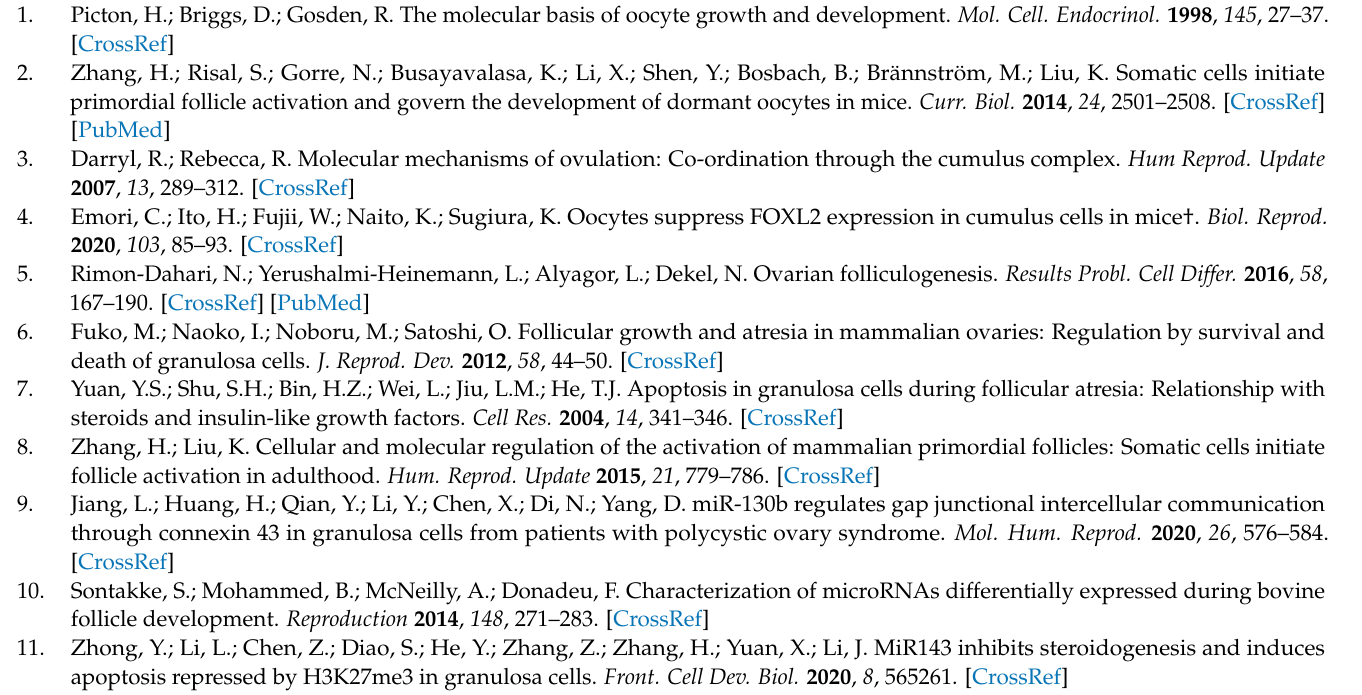
Table S1: Sequences of primers and oligos